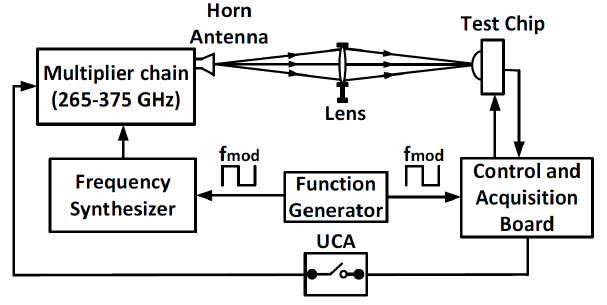
Figure 15. Block diagram of the THz characterization